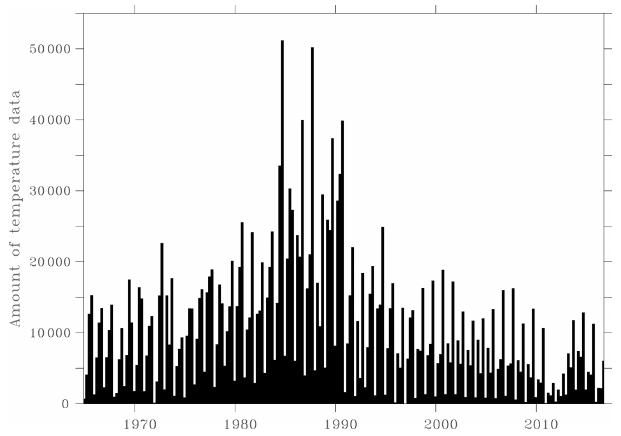
Figure 2. Availability of temperature data in the Barents Sea as a function of time (seasons).